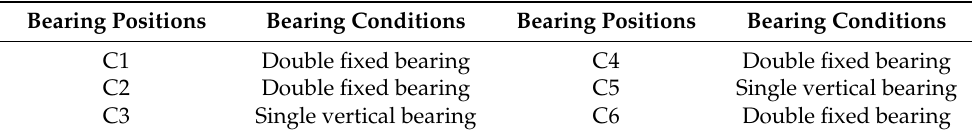
Table 1. Bearing conditions of the typical irregularly-shaped bridge.